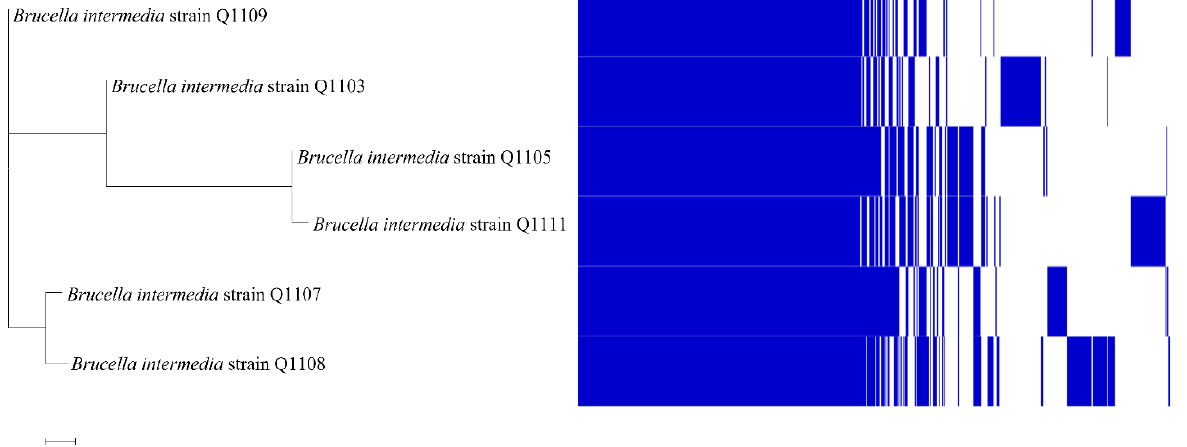
Figure 7. Pangenome analysis of the isolated B. intermedia strains carried out using the Roary software. Left : core-genome phylogeny, right : genes heatmap. The scale represents 20% nucleotide sequence divergence.